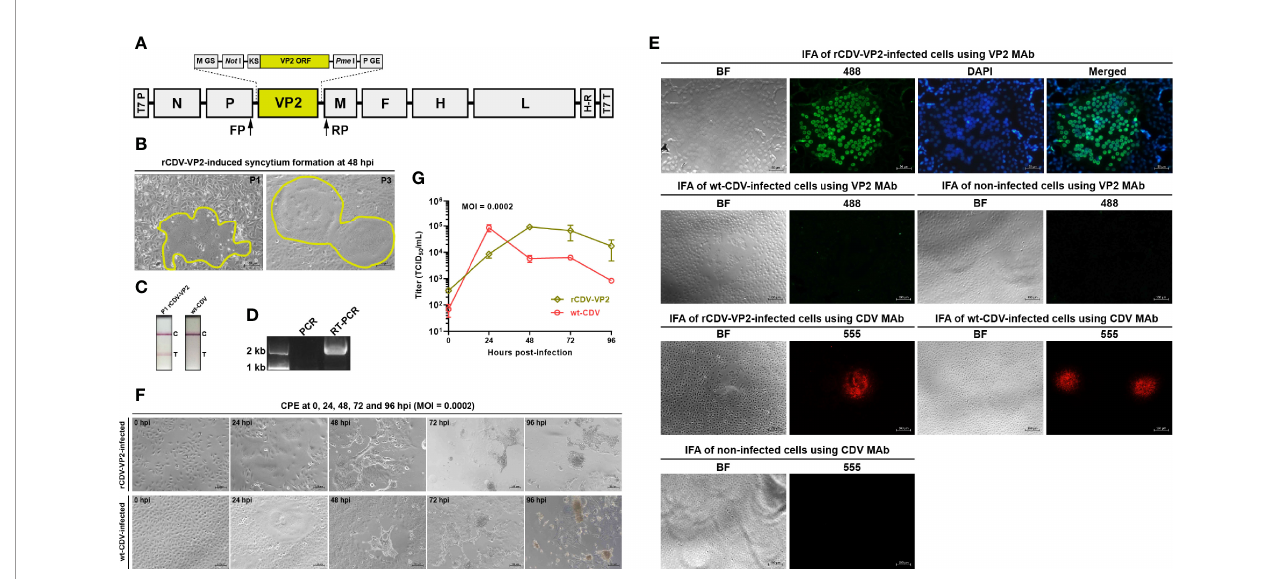
FIGURE 1 | Rescue, identi fi cation, and characterization of rCDV-VP2. Schematic representation of rCDV-VP2 cDNA clone (A) . T7 P, T7 promoter; GS, gene start; GE, gene end; KS, Kozak sequence; H-R, hepatitis delta virus ribozyme; T7 T, T7 terminator. Syncytium formation on Vero-Dog-SLAM (VDS) cell monolayers during viral passaging (B) . Detection of rCDV-VP2- and wt-CDV-infected cell cultures by CPV-2 test strips (C) . T, test; C, control. RT-PCR analysis of P7 rCDV-VP2 using FP/RP (D) . The PCR assay is designed for exhibiting whether cDNA clone residues interfere with the RT-PCR analysis. Immuno fl uorescence assays (IFAs) of VP2 expression and rCDV-VP2 infection (E) . VP2 MAb (primary antibody) and Alexa Fluor ® 488 conjugate (secondary antibody) are used for the IFA of VP2 expression; CDV MAb (primary antibody) and Alexa Fluor ® 555 conjugate (secondary antibody) are used for the IFA of rCDV-VP2 infection. CPEs on VDS cell monolayers infected (MOI = 0.0002) either with the P15 rCDV-VP2 or with the wt-CDV at 0, 24, 48, 72, and 96 hpi (F) . Multistep growth curves of the P15 rCDV-VP2 and the wt-CDV within 96 hpi (G) . Data at each time point are representative of three independent